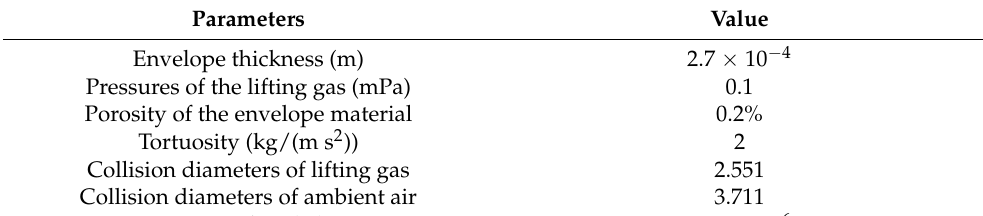
Table 2. Design parameters used for analyzing an envelope diffusion coefficient.